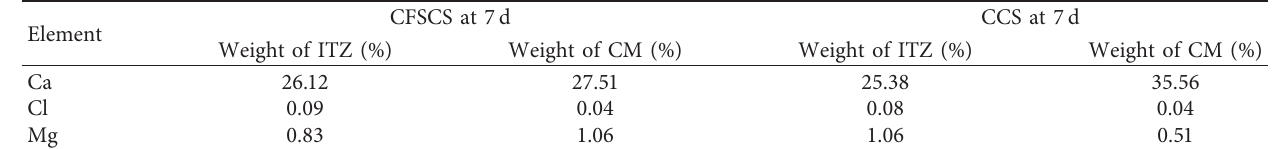
Table 6: EDS analysis of mortar samples at 7d.